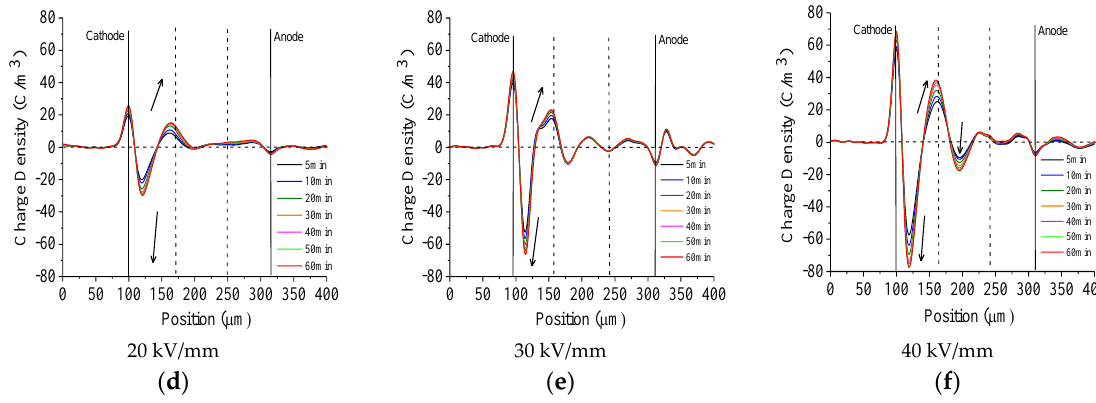
Figure 2. Space charges trapped in the oil impregnated insulation paper with new and aged oil under DC 20 kV/mm, 30 kV/mm, and 40 kV/mm. ( a ) sample with new oil (20 kV/mm); ( b ) sample with new oil (30 kV/mm); ( c ) sample with new oil (40 kV/mm); ( d ) sample with aged oil (20 kV/mm); ( e ) sample with aged oil (30 kV/mm); ( f ) sample with aged oil (40 kV/mm).